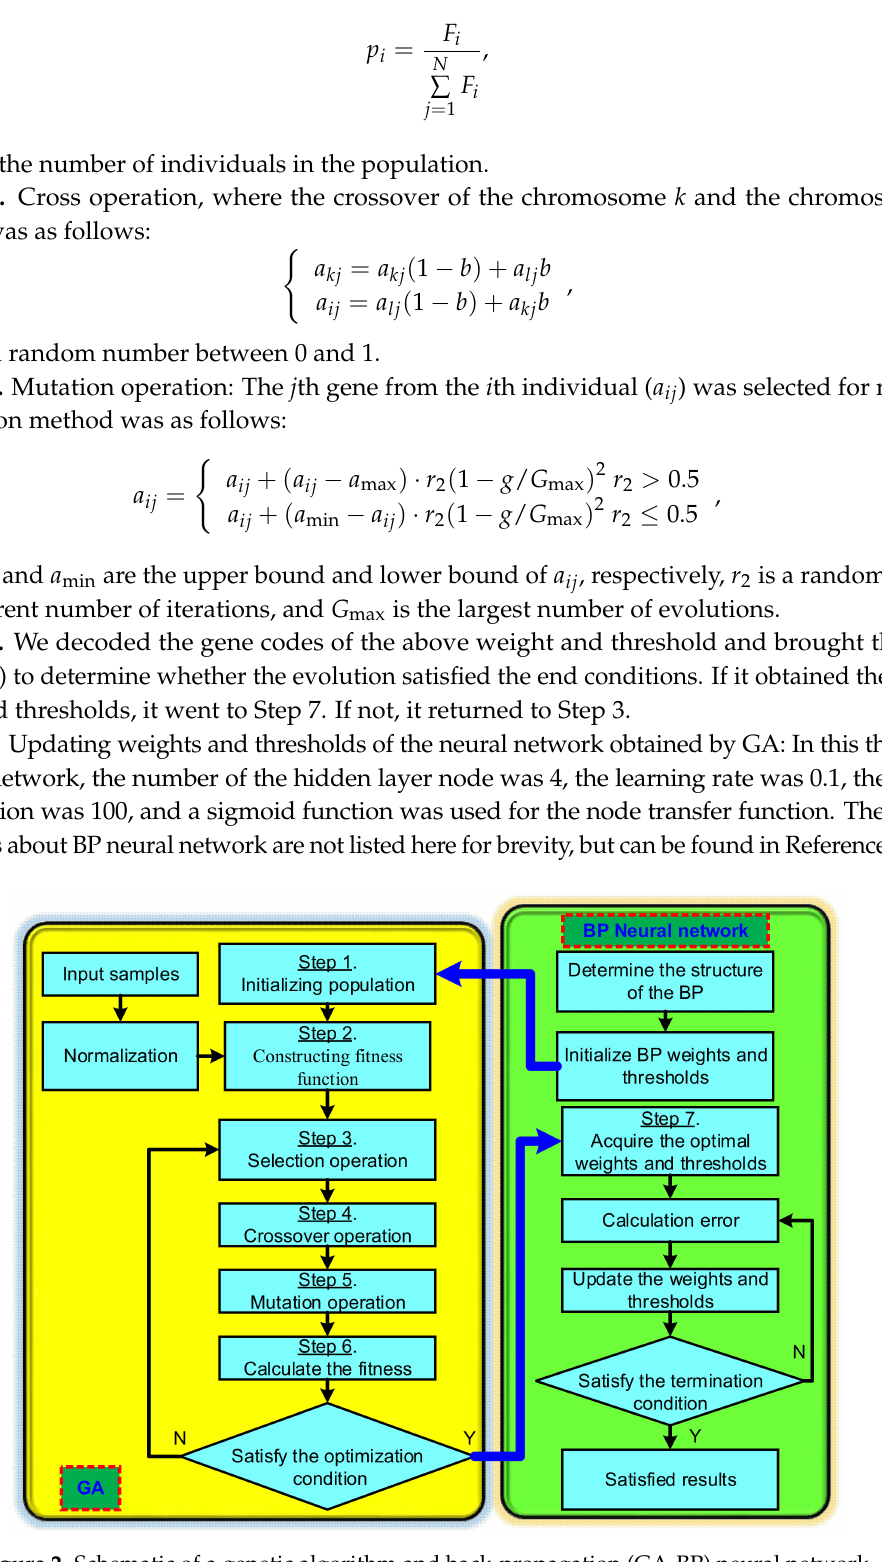
Figure 2. Schematic of a genetic algorithm and back-propagation (GA-BP) neural